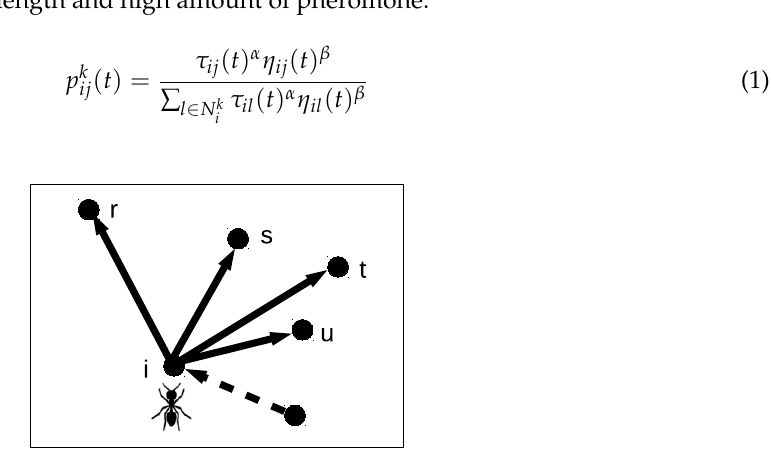
Figure 1. The ant k is at node i and must select the next node of its path from N k